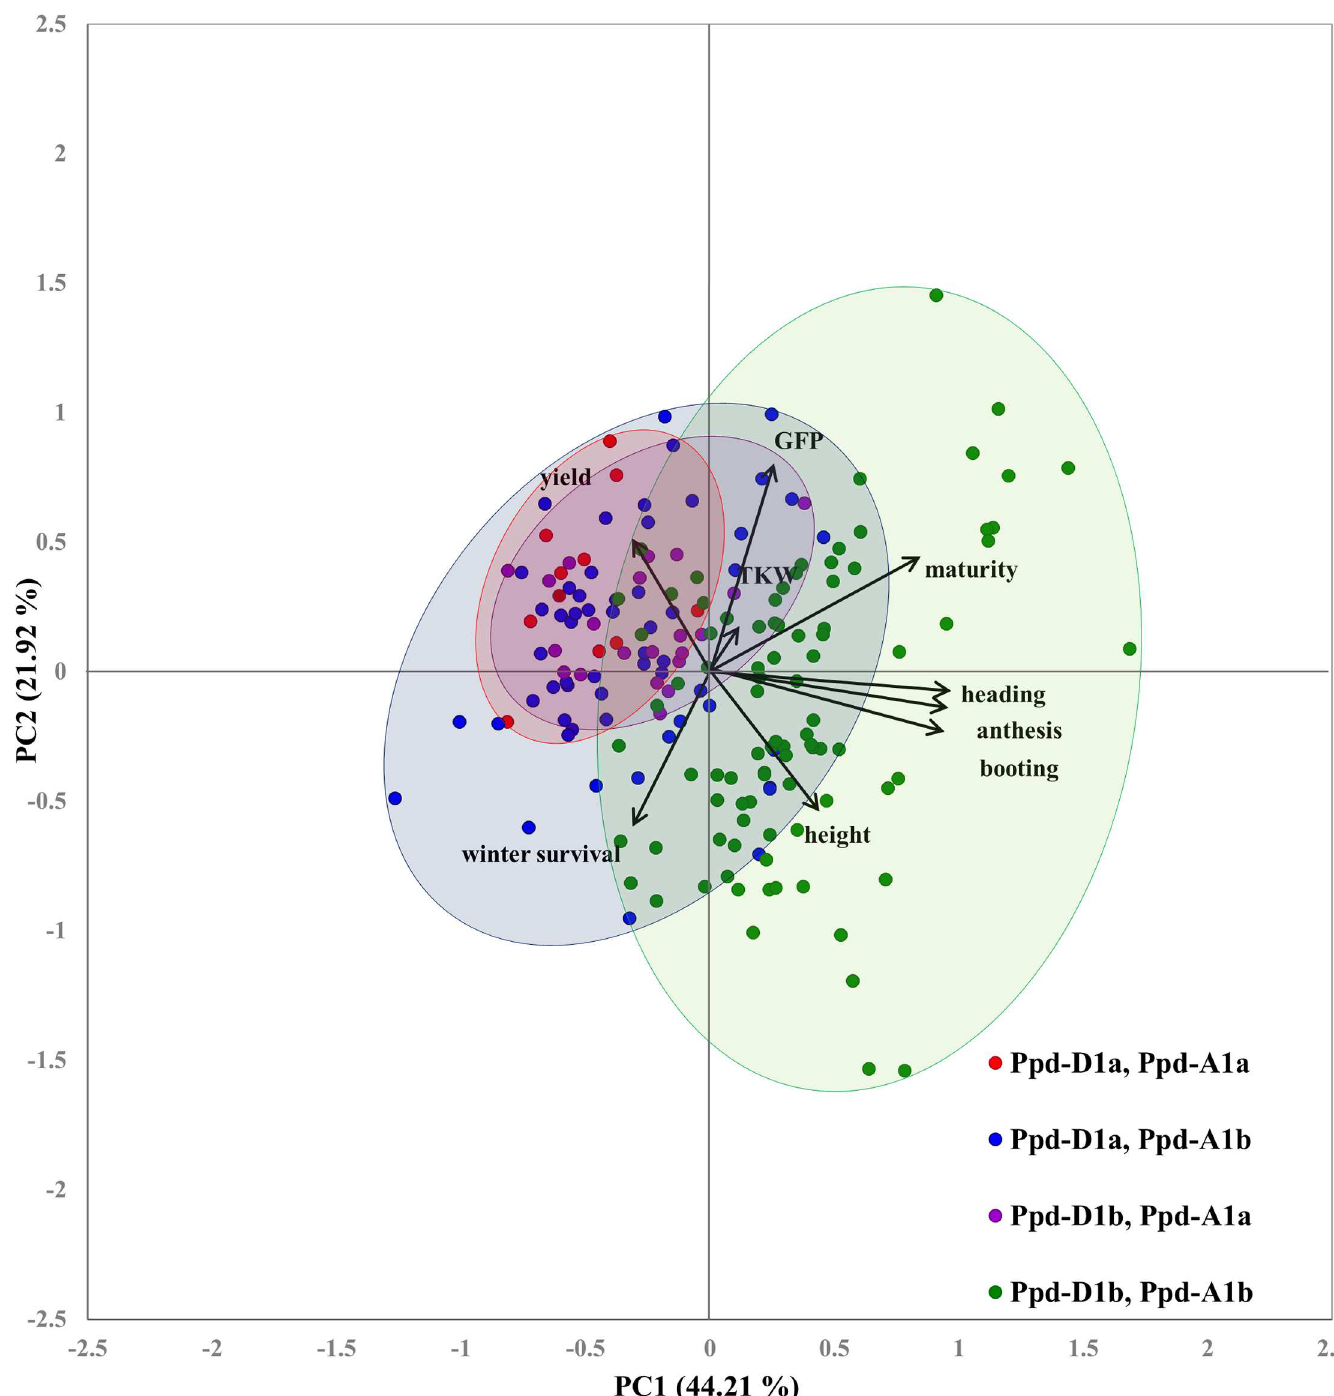
Fig 3. Biplot of the principle component analysis of the genotype by trait matrixes for 2015 and 2016 for 203 genotypes tested in fall-seeded trials in Ontario, Canada.